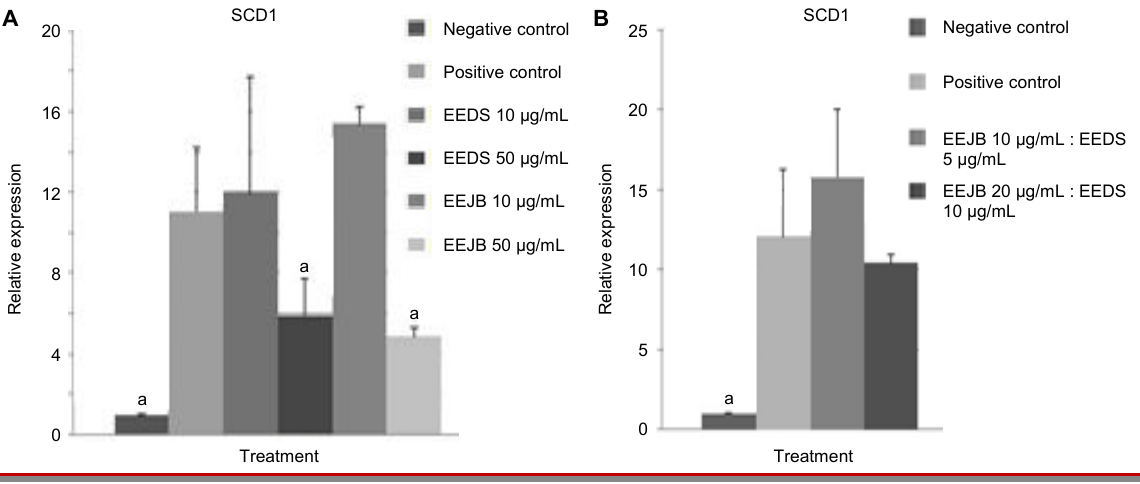
Figure 3: Relative expression of adipogenesis-related gene, SCD1 in 3T3-L1 cells. (a) Effects of single ethanol extract of Detam 1 soybean (EEDS) or ethanol extract of Jati belanda leaves (EEJB) treatments in concentration of 10 µg/mL and 50 µg/mL; (b) Ef- fects of combination of ethanol extract of Jati belanda leaves and ethanol extract of Detam 1 soybean treatments in concentration of 10 µg/mL, 5 µg/mL and 20 µg/mL, 10 µg/mL (*p<0.05, significant compared to positive control, Duncan post-hoc test)